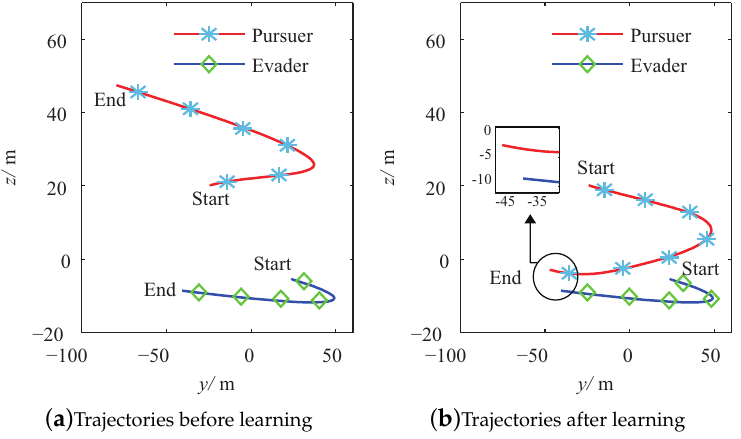
Figure 6. Trajectories of the pursuer and the evader in the Y – Z